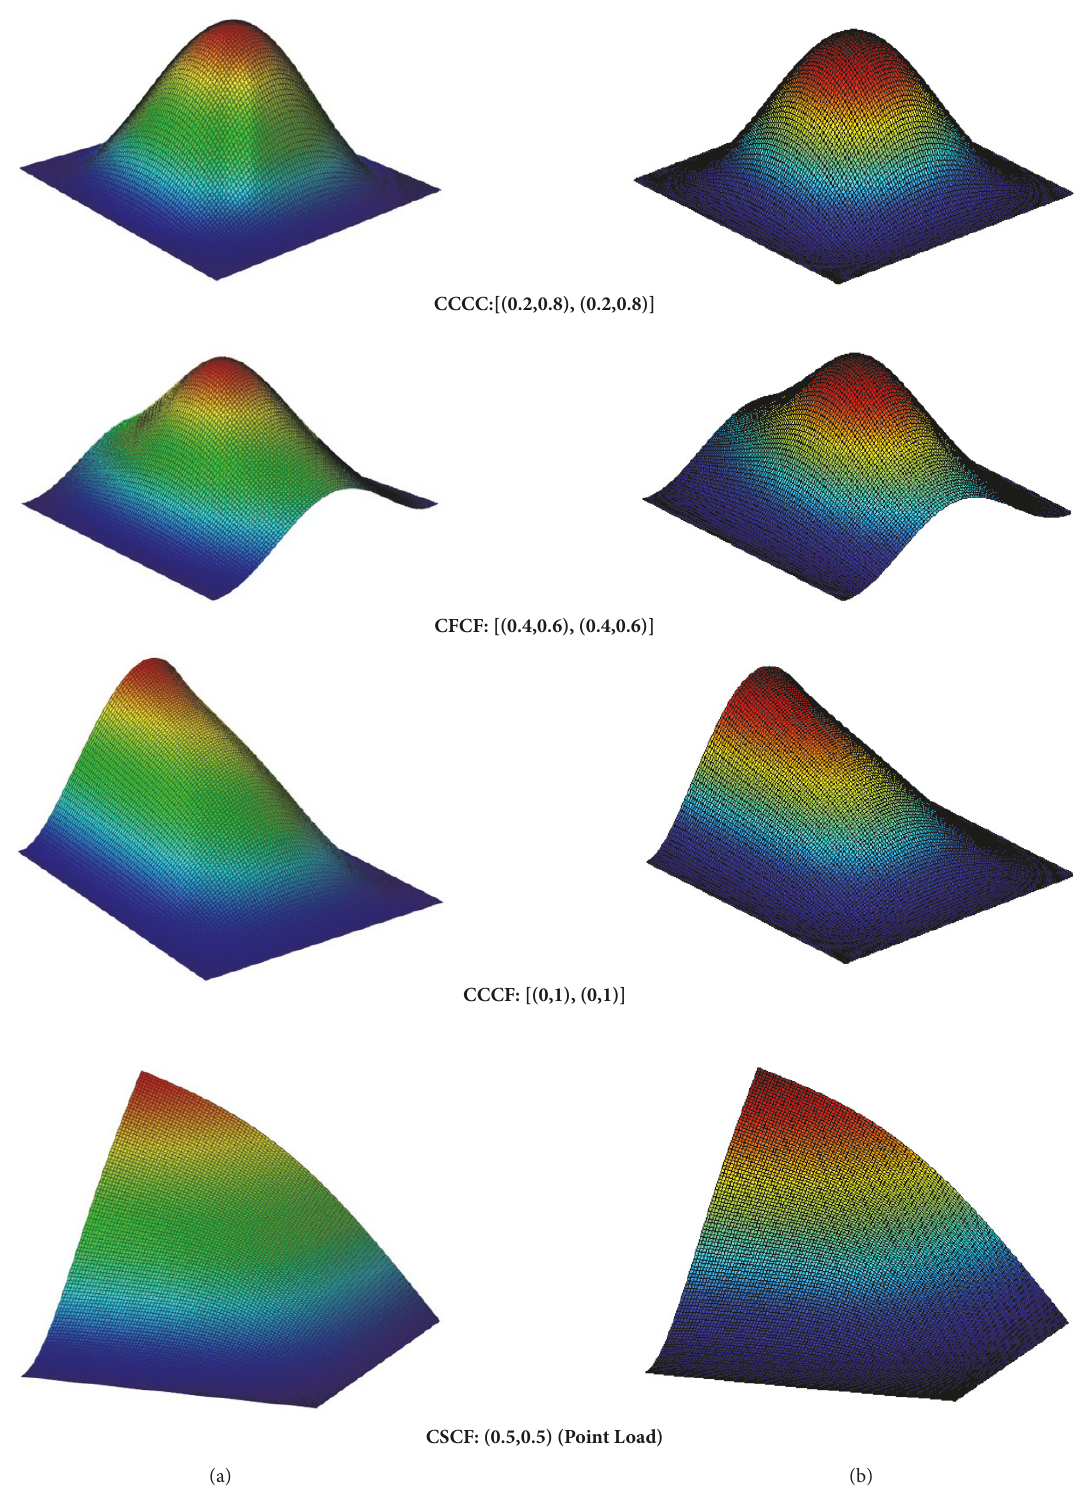
Figure 3: Static deflection of an isotropic plate under different loads: (a) finite element (ABAQUS); (b) current